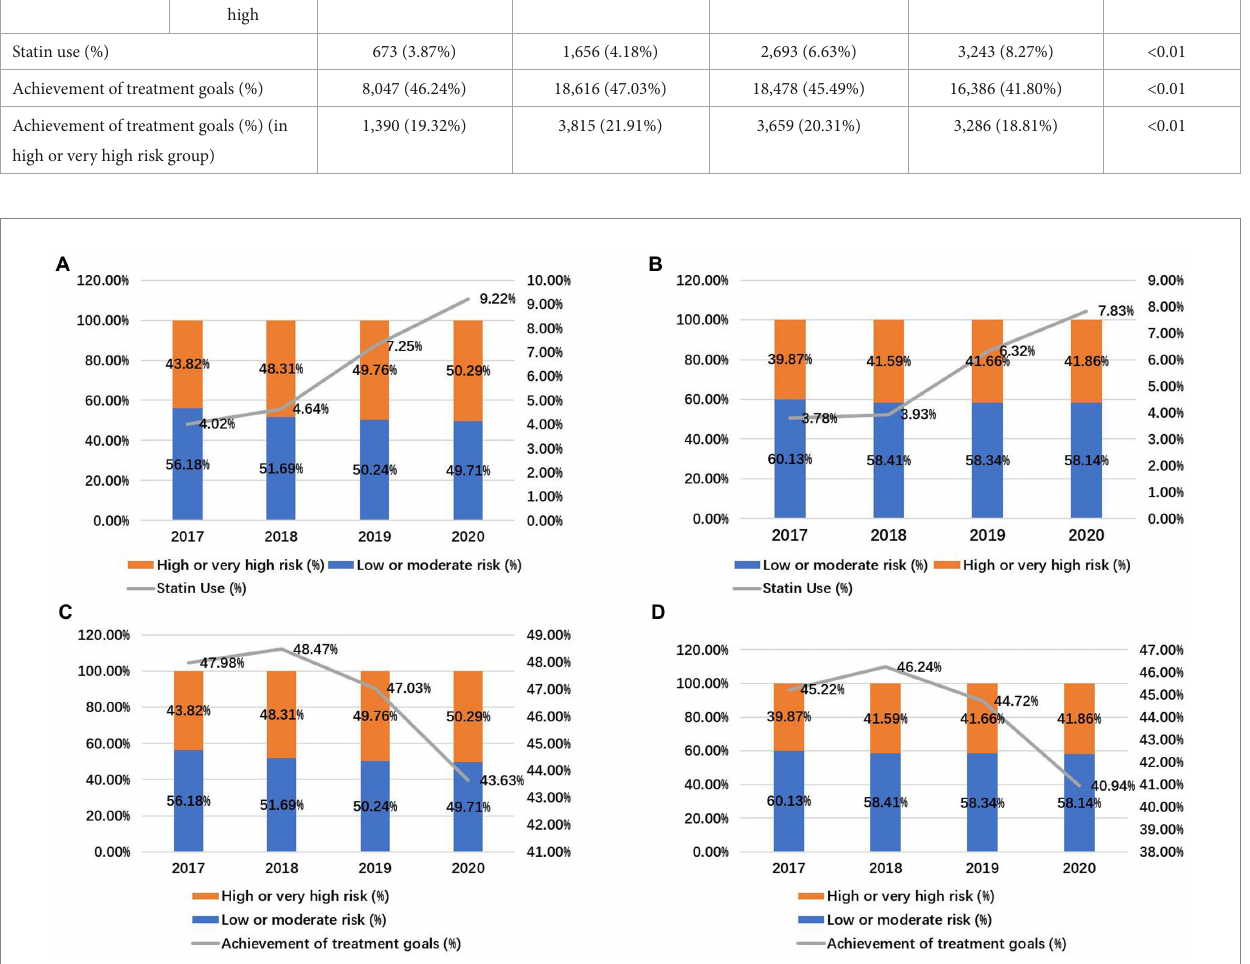
FIGURE 2 Statin use and achievement of treatment goals in older adults. Statin use in participants > 75 years old (A) and ≤ 75 years old (B) . Achievement of treatment goals in participants > 75 years old (C) and ≤ 75 years old (D)